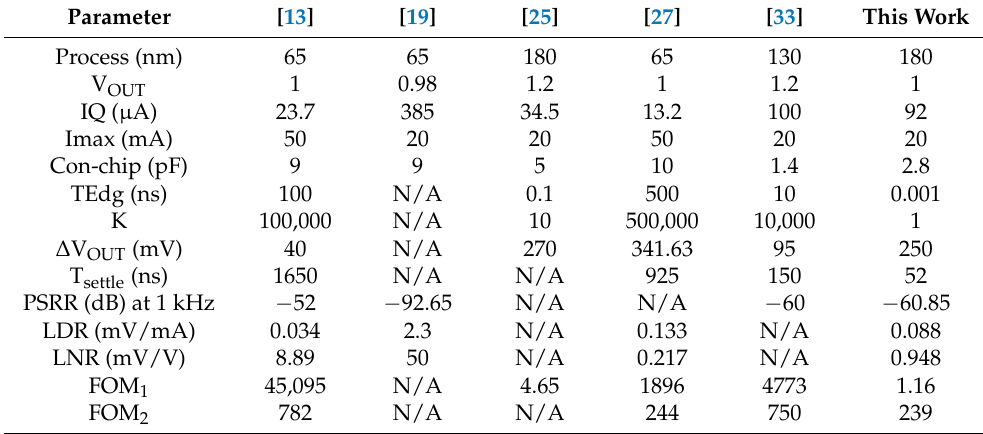
Table 1. Performance summary and comparison with the prior state of the art.